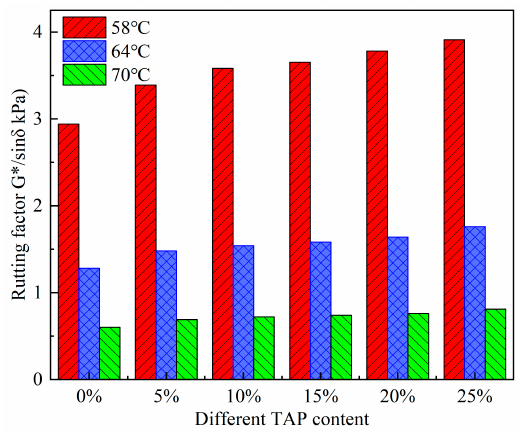
Figure 3. The rutting factors of TAPMA.